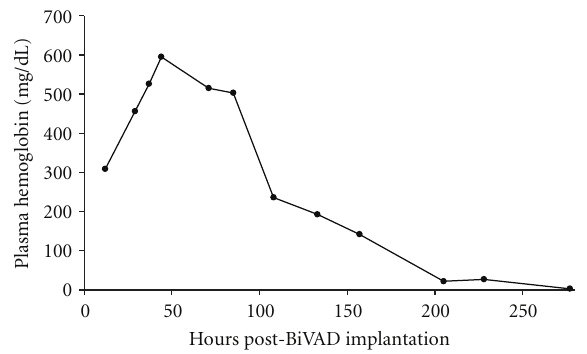
Figure 3: Transesophageal echo demonstrating the pulmonary insu ffi ciency was believed to be secondary to the position of the outflow cannula of the right ventricular assist